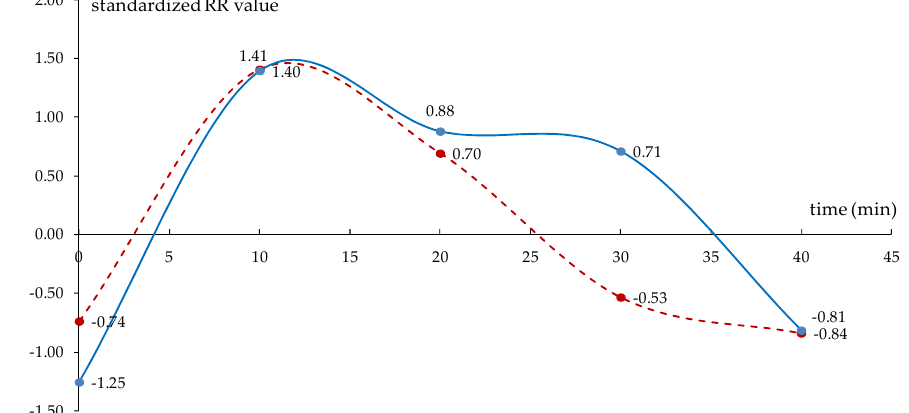
Figure A2. Temporarily disaggregated series of the RR–MGS Huichapan (red line) and RR–satellite image (blue line) during the Hurricane Manuel (16 Sep 2013), Step (ii).